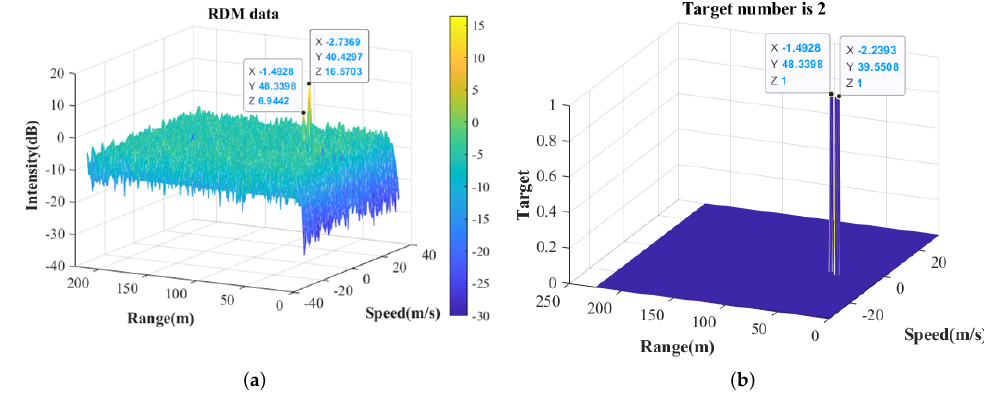
Figure 16. CFAR detection example. ( a ) RDM data. ( b ) CFAR result.